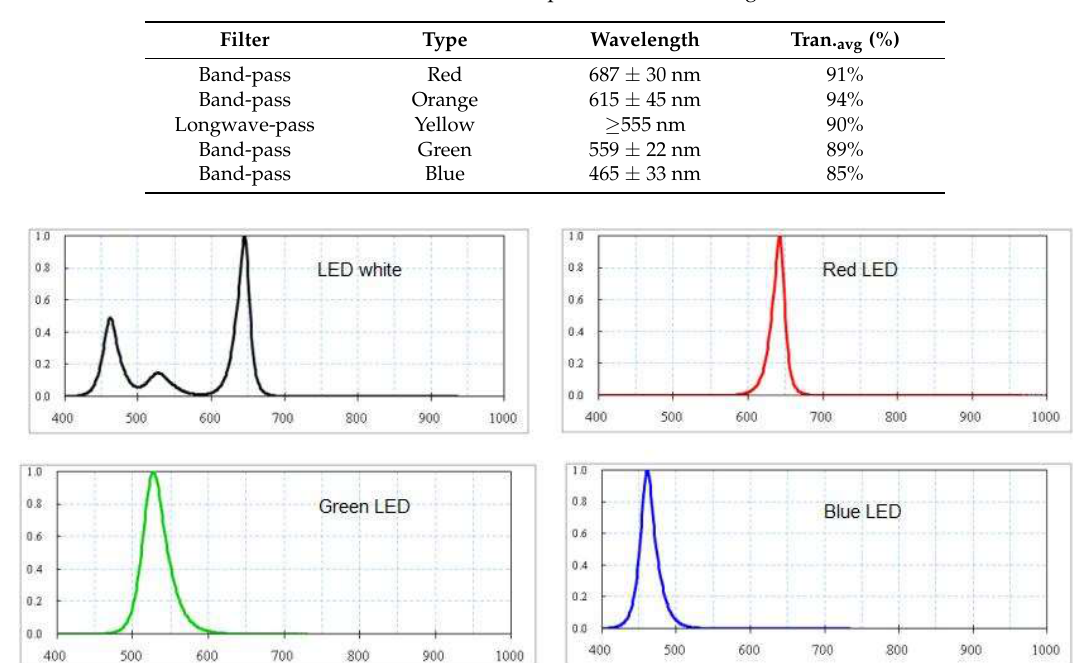
Figure 4. Spectrum distribution of LED light source.